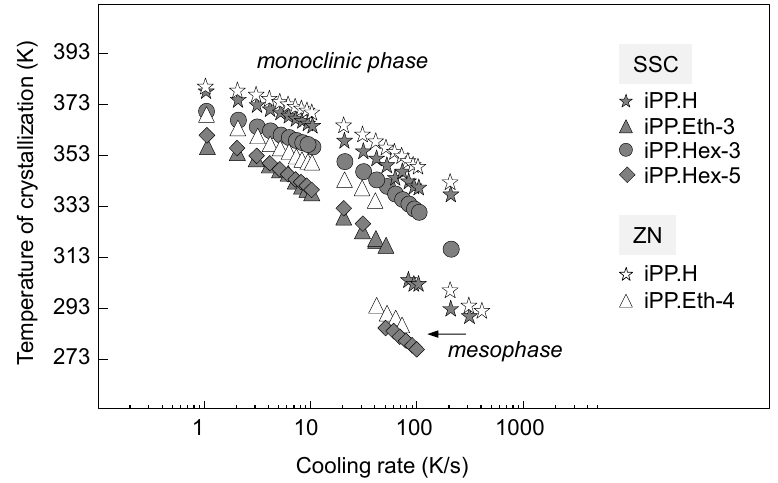
Figure 3. Temperature of crystallization as a function of cooling rate for homopolymers and random copolymers of propylene based on either SSC or ZN catalysts.